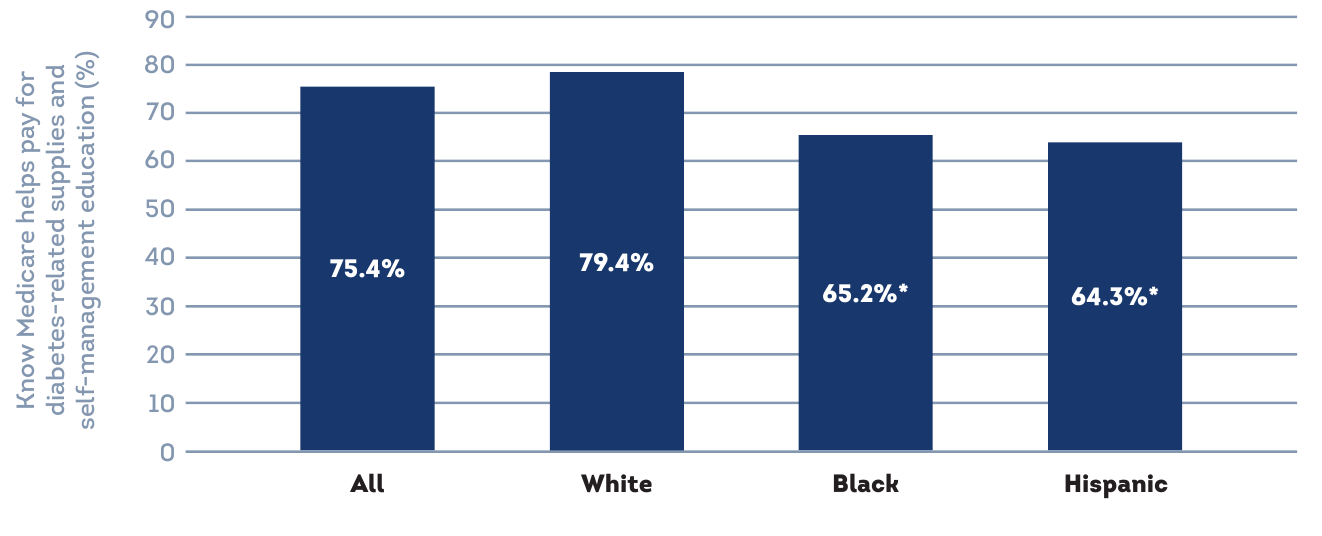
Figure 5. Percentage reporting they know Medicare helps pay for diabetic testing supplies and self-management education, among community-dwelling Medicare beneficiaries with self-reported diagnosed diabetes, by race/ethnicity